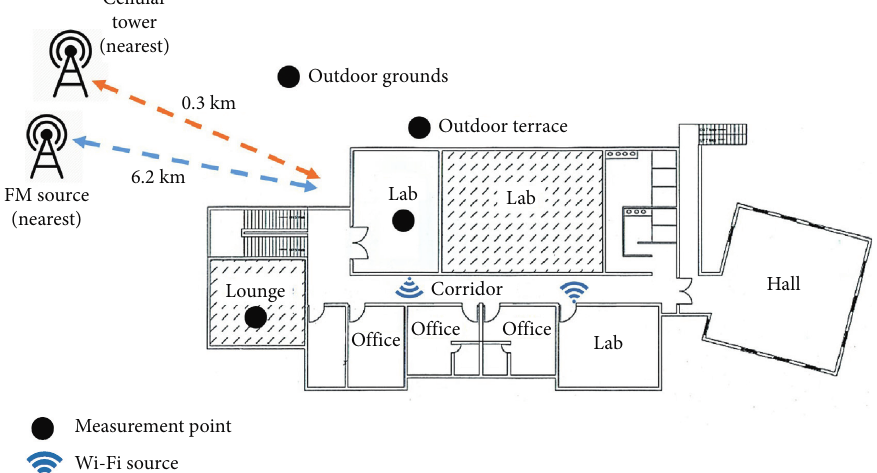
Figure 5: Floor plans of testing site with nearest energy harvesting sources (distances are not realistic and have been scaled down to fit image).